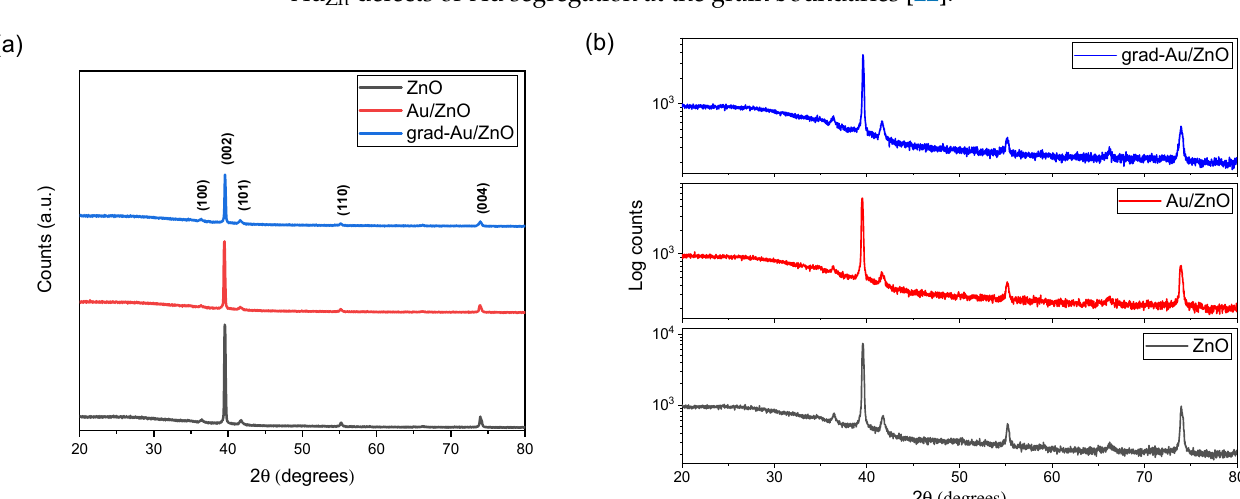
Figure 1. XRD patterns ( a ) in linear and ( b ) in logarithmic scale of ZnO, Au/ZnO, and grad-Au/ZnO NRs photoanodes.